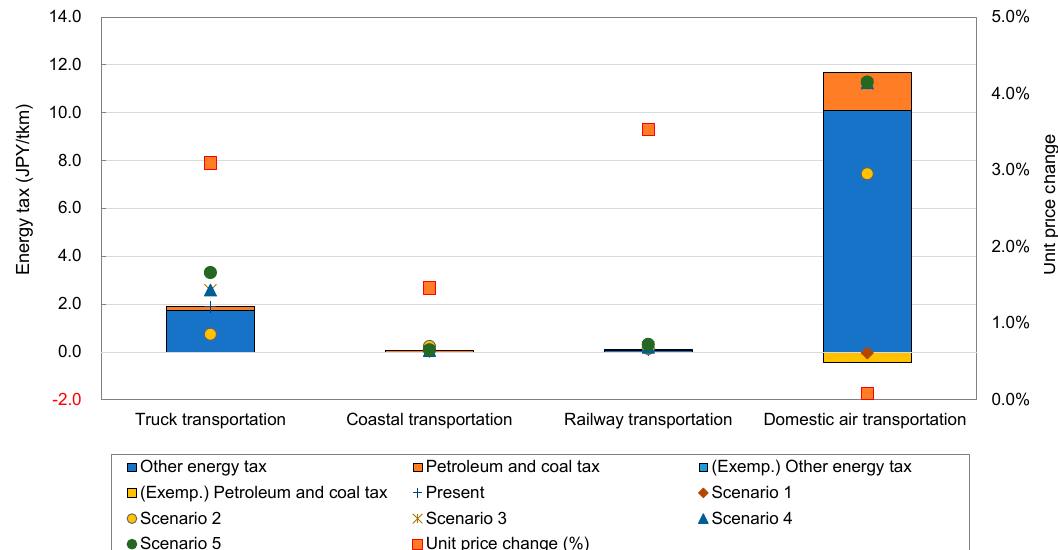
Figure 7. Changes in product taxes and product prices in materials under different taxation scenarios. The bar graphs show the present taxation breakdown. The percentage change in product prices compares the present with Scenario 5.